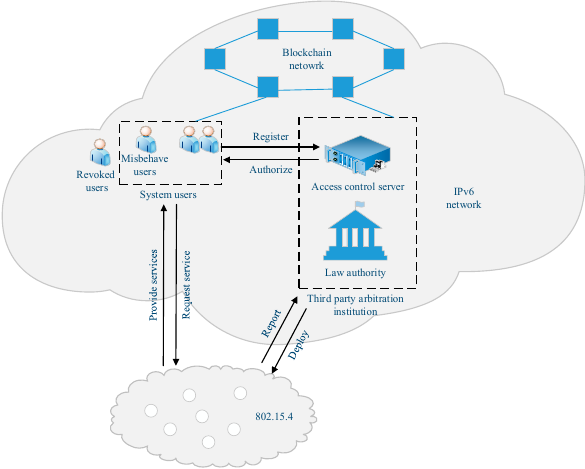
Figure 1. Access control system architecture.